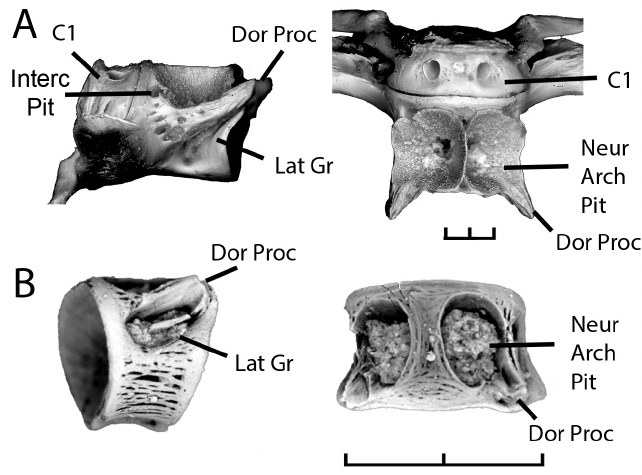
Figure 18. Centrum of Weberian apparatus of ostariophy - san designated Teleost U-3/BvD compared with the fused second and third centra of the Weberian apparatus of the cyprinid Cyprinus carpio . A) first to third centra of the Weberian apparatus of Cyprinus carpio , TMP 2007.30.9. B) trum of the Weberian apparatus of Teleost U-3/BvD, UALVP 48890. Centra left lateral and dorsal views. Scale bar equals 2 mm. Abbreviations: C1, centrum one; Dor Proc, dorsal process; Interc Pit, interclarium articular pit; Lat Gr, lateral groove; Neur Arch Pit, neural arch articular